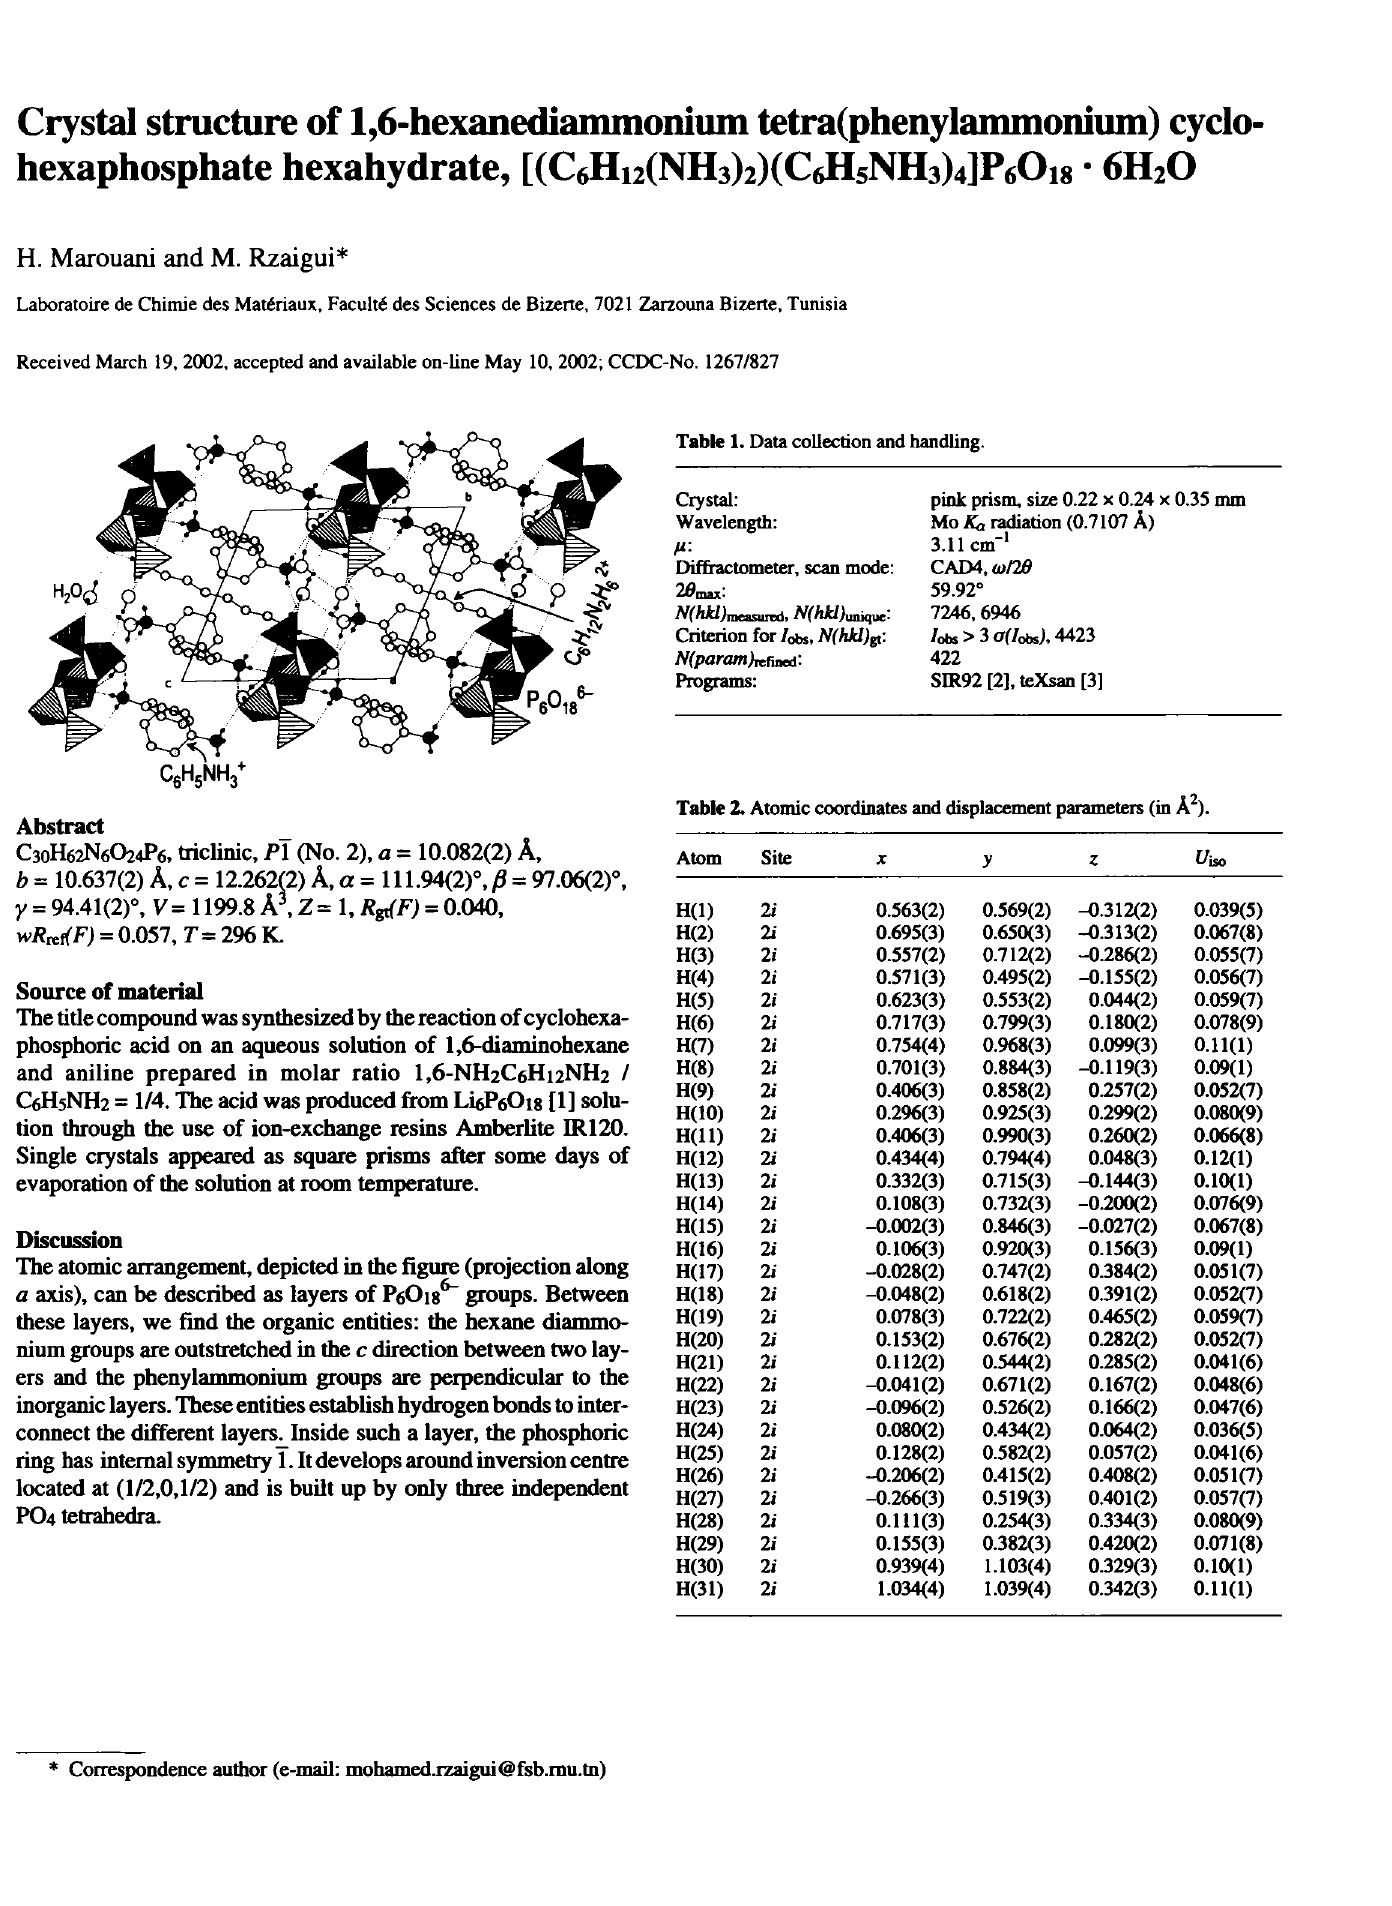
Table 1. Data collection and handling.